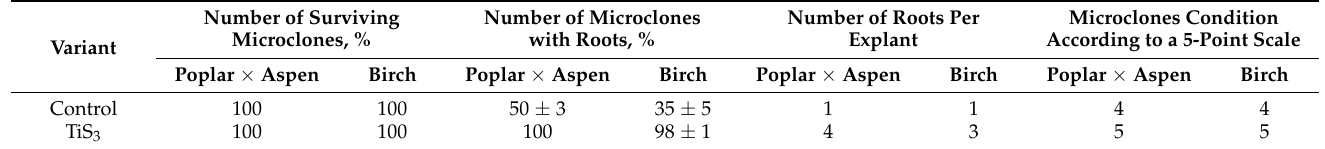
Table 2. TiS 3 effects at the rooting stage.